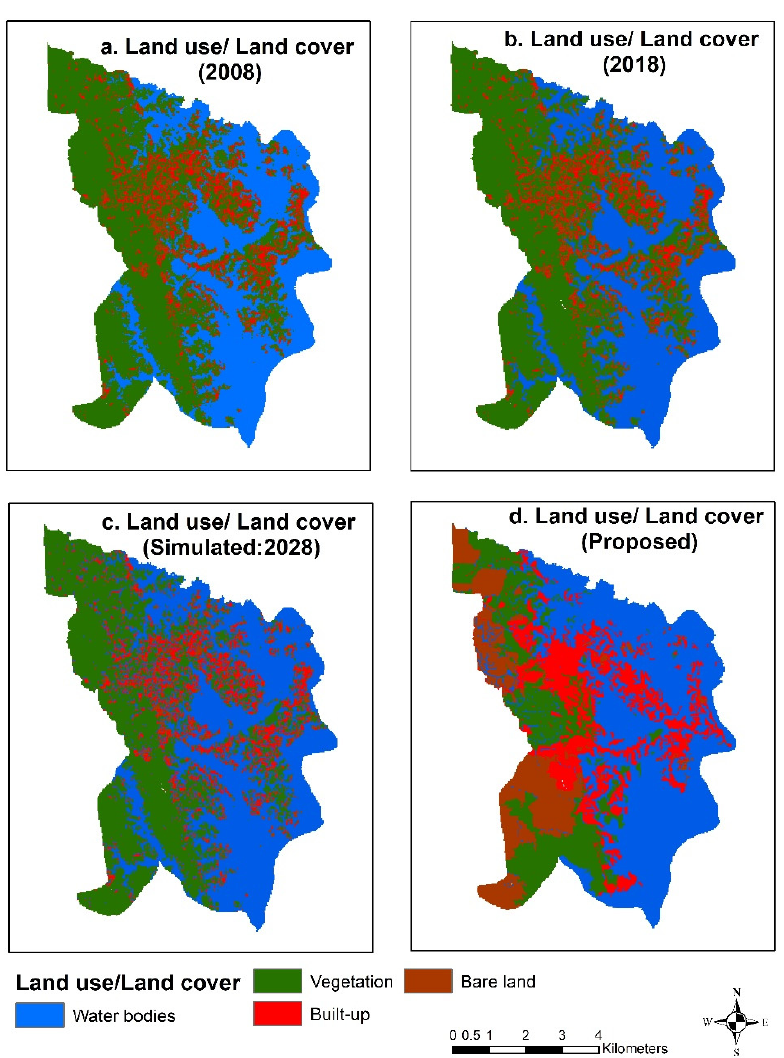
Figure 3. Land use/land cover maps (dynamic causal factors): ( a ) land use/land cover of 2008, ( b ) LULC of 2018, ( c ) simulated LULC (2028), ( d ) proposed land use/land cover. Existing LULC of 2018